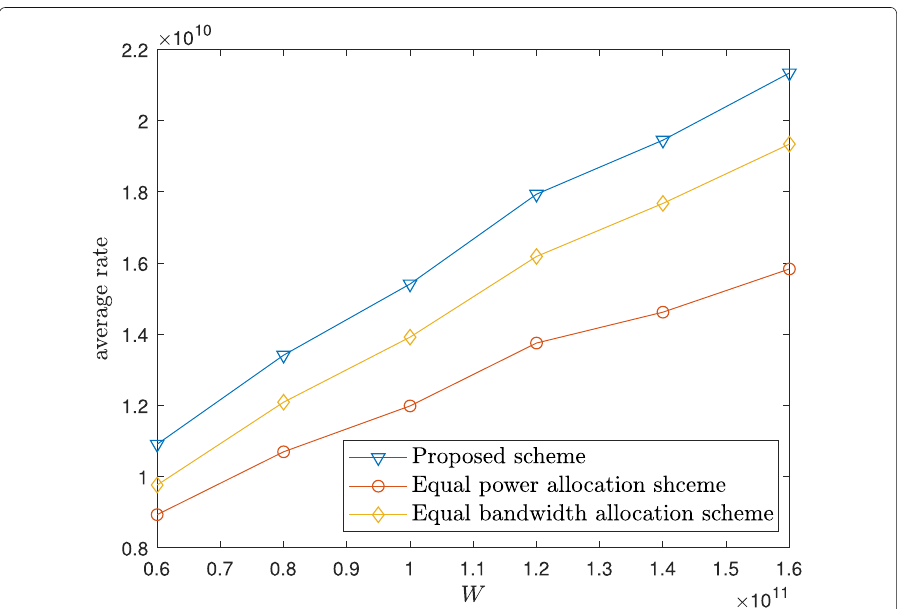
Fig. 7 The time-averaged rate versus the bandwidth W with different